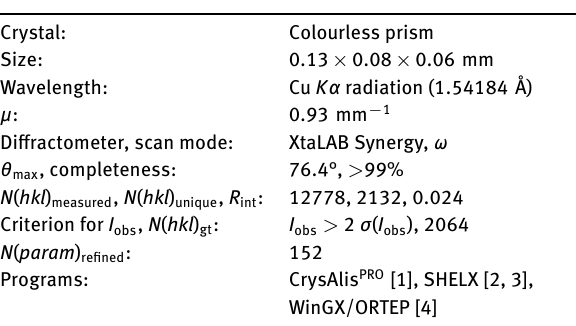
Table 1: Data collection and